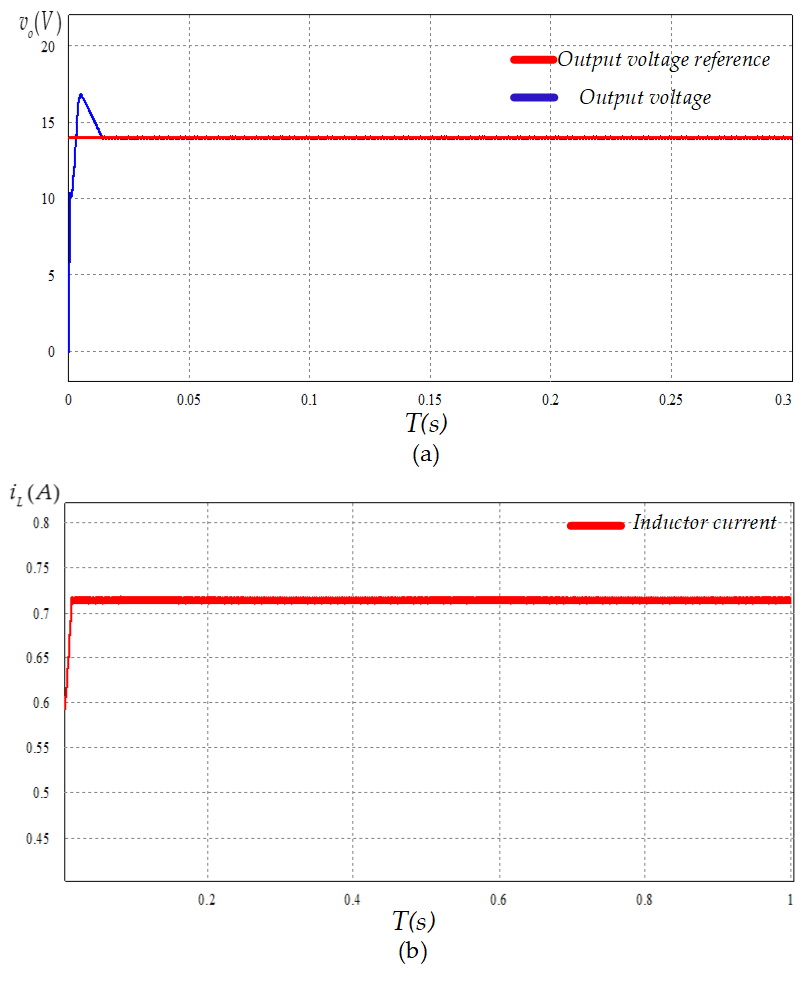
Figure 10. Closed-loop response of the system: ( a ) output voltage; ( b ) inductor current.